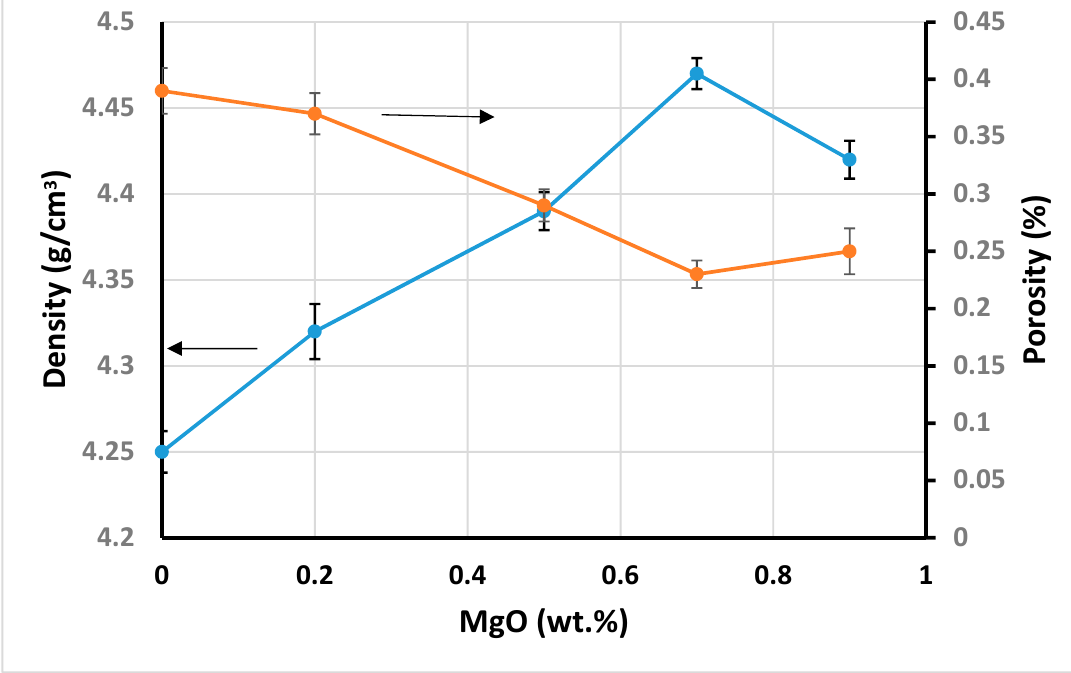
Figure 4. Effects of MgO on density and porosity of samples.